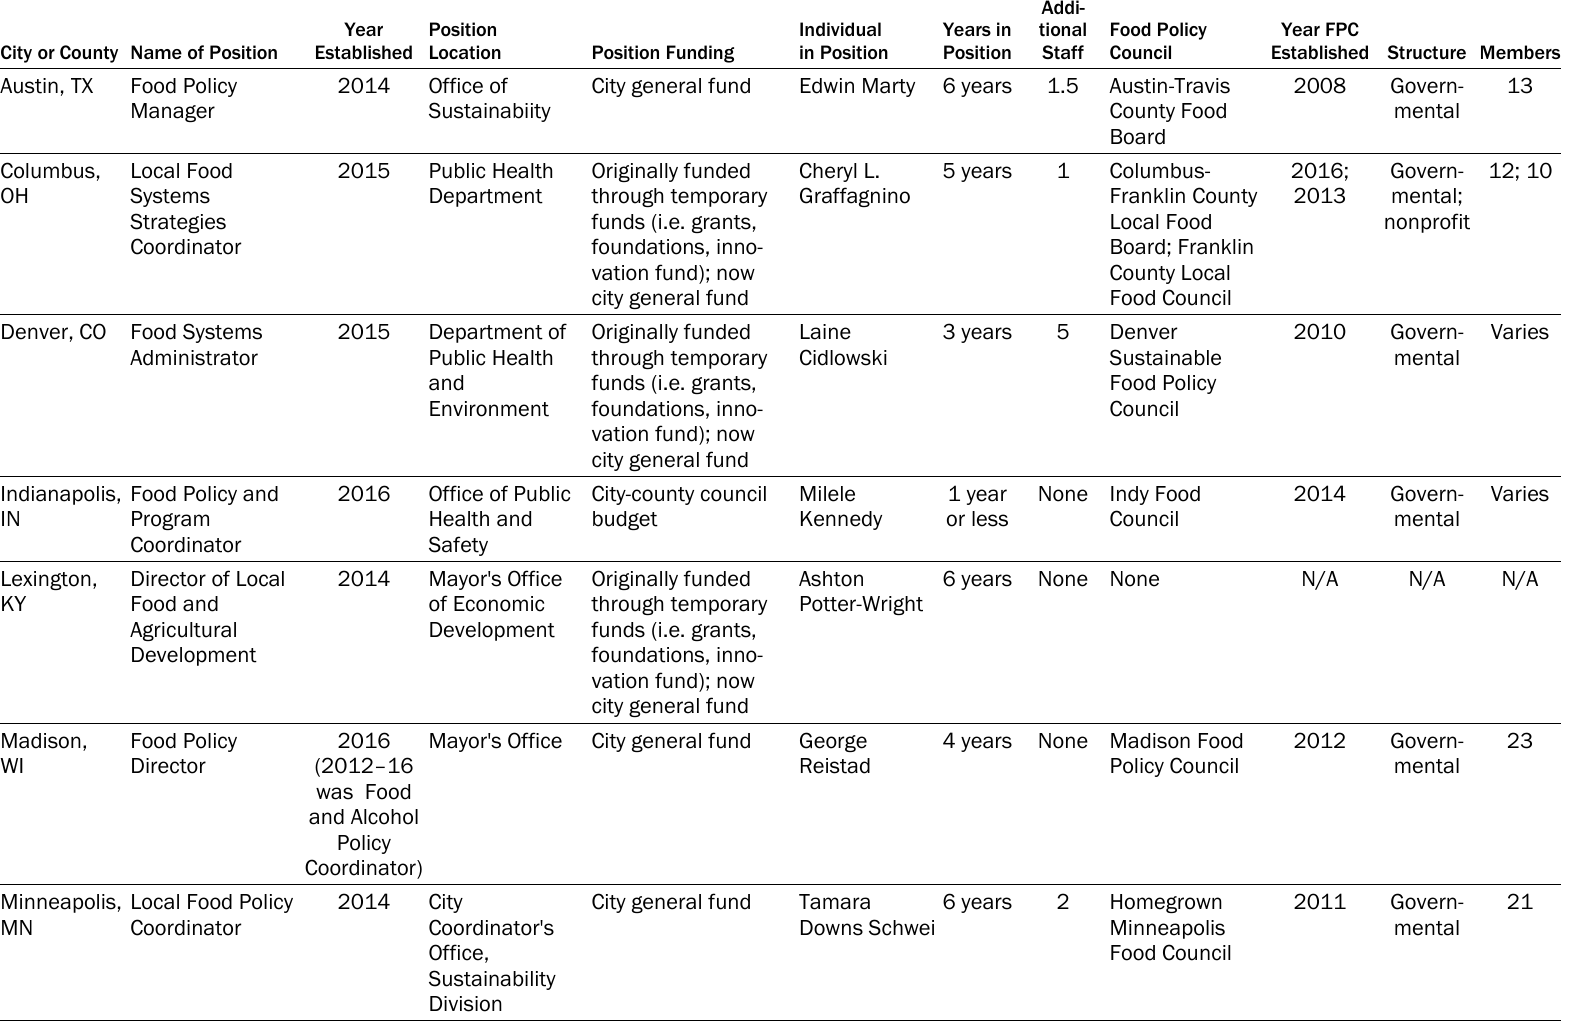
Table 1. Description of Eleven Positions and the Respective Food Policy Council as of May 2020